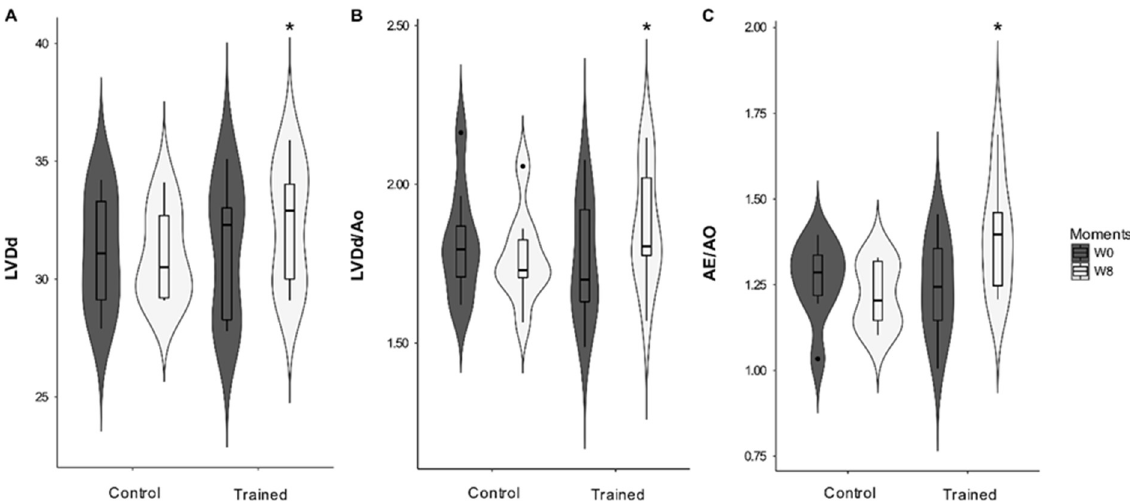
Figure 2. Changes in cardiac morphology of dogs submitted to eight weeks of training. ( A ) LVDd: left ventricular internal diameter at the end of diastole; ( B ) LVDd/Ao: left ventricular internal diameter at the end of diastole to aorta ratio; ( C ) LA/Ao: left atrium-to-aorta ratio. Bars are standard errors. *: Difference from week zero (W0); ( p < 0.05).